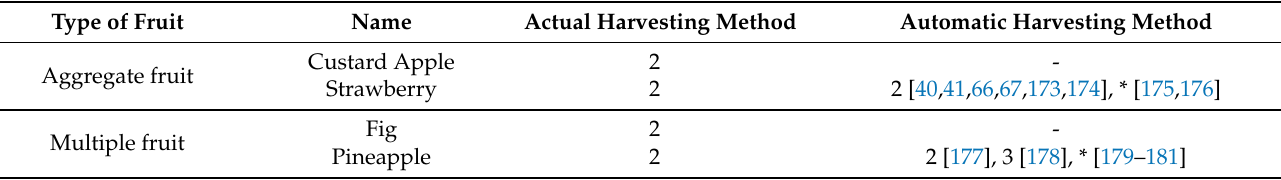
Table 3. Aggregate and multiple fruit